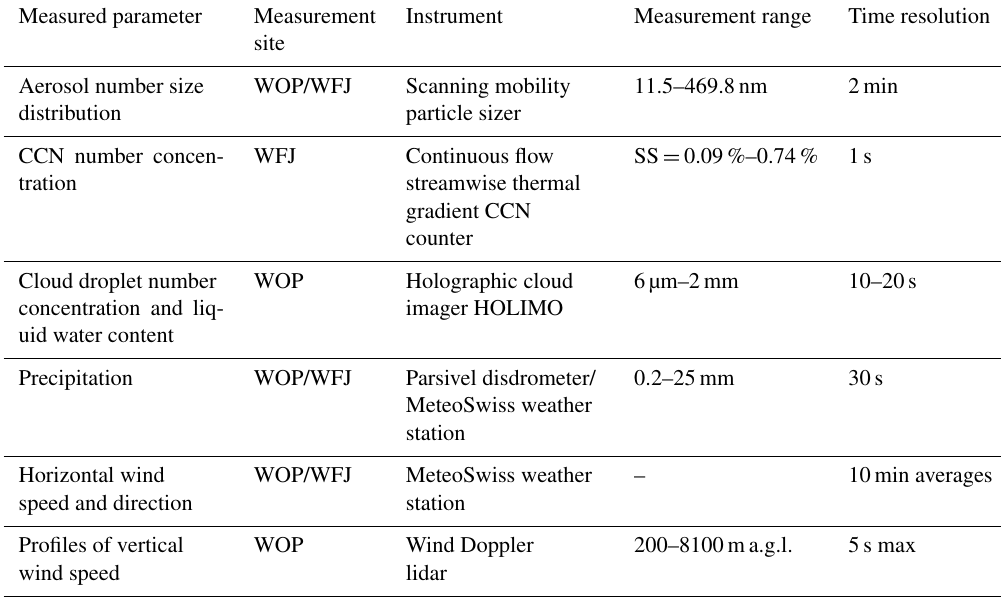
Table 1. Overview of data sources from the RACLETS campaign used for this study. Along with the observed parameters, the corresponding instrumentation, measurements range, and time resolutions are